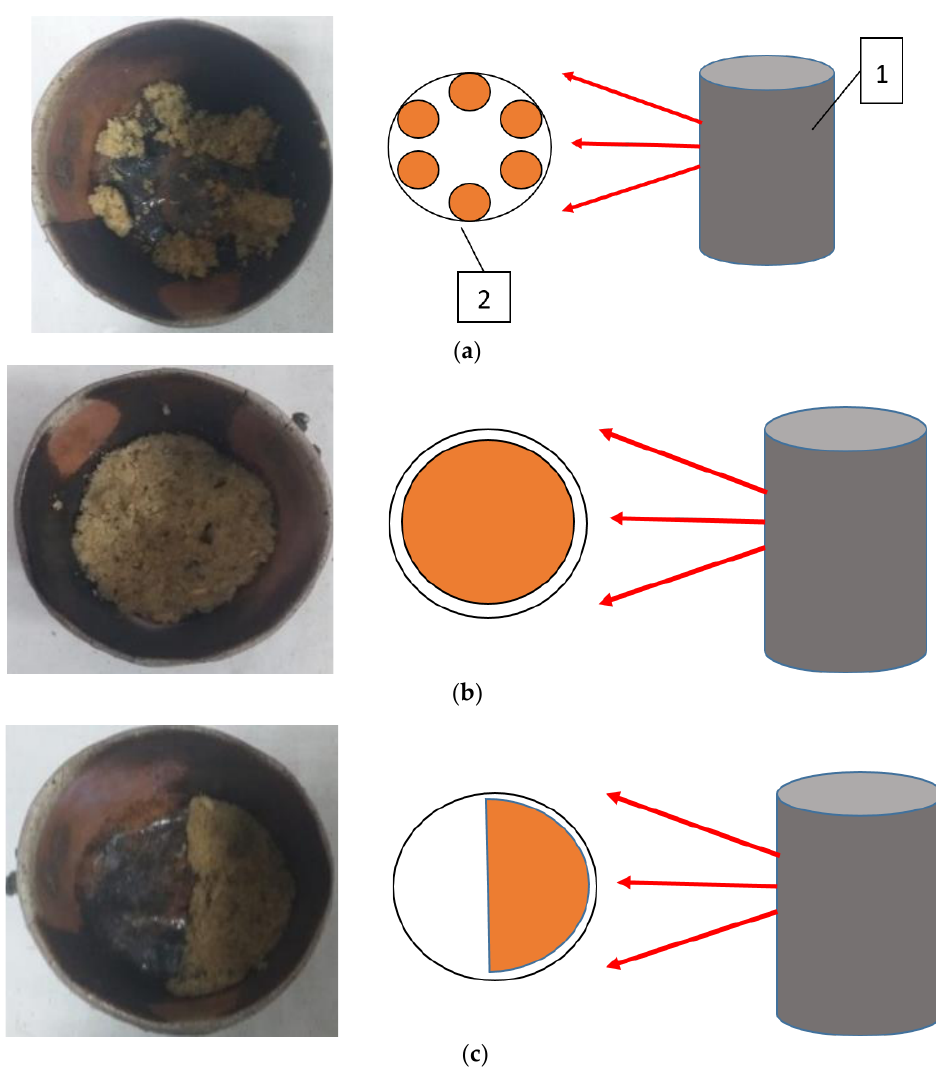
Figure 3. The distribution of the biomass in the crucible: along the edges ( a ); uniform distribution over the entire crucible bottom ( b ); on half of the crucible bottom ( c ); magnetron (1); biomass (2).